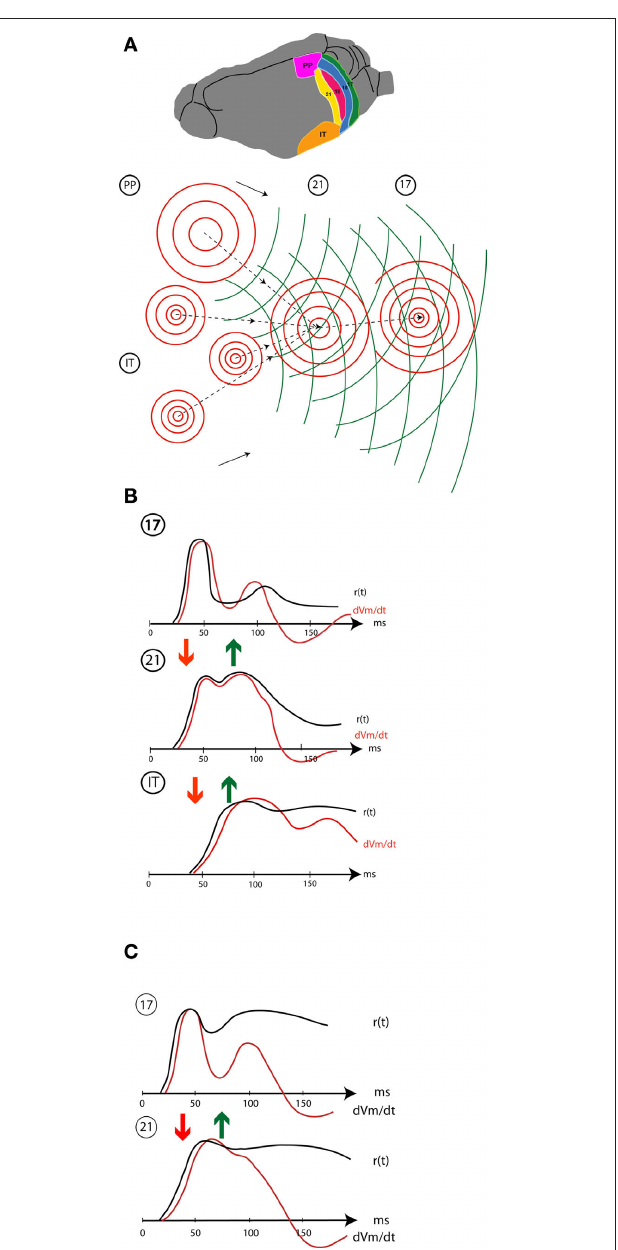
Figure 5 | Schematic display of spatio-temporal dynamics of the population firing rates, r ( t ), membrane potentials and population d V /d t m (net membrane current) in areas 17,21,and visual temporal cortex (iT). (A) occipital, temporal, and parietal (PP) visual areas in the ferret showing the mapping and lateral spreading excitation (red) in response to a small stationary object appearing in the field of view. The object is mapped once in the retinotopically organized areas 17 (18, 19 not shown) 21, and PP, but several places in IT (non-retinotopic). The focused excitatory FB shown by stippled curves with arrows and the broad FB propagation is shown in green. (B) Stationary object appearing at time 0: temporal dynamics of the population firing rates and the d V /d t at the mapping sites in areas 17, 21, and IT. Initially m the local r ( t ) drives the d V /d t (based on Salazar et al., 2004; Eriksson et al., m 2008; Roland unpublished; Chen et al., 2007). (C) Moving object: r ( t ) and d V / m d t at the initial mapping sites in areas 17 and 21 (modified after Harvey et al., 2009). Arrows show the communication directions (FF red, FB